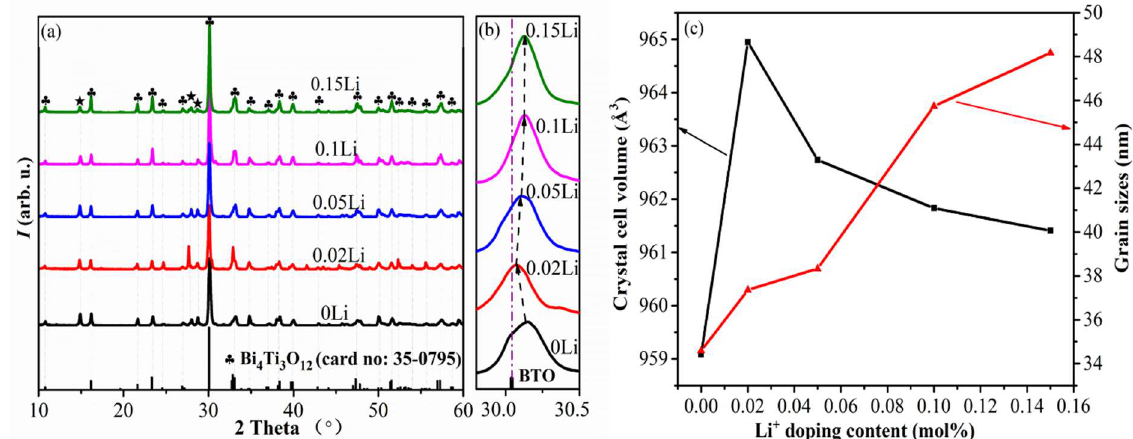
Figure 1. ( a ) XRD pattern, ( b ) an enlarged XRD graph in the range of 2 θ = 29.8°–30.5°, and ( c ) the volume of crystal cell and grain sizes of BHYTO: x Li phosphors.